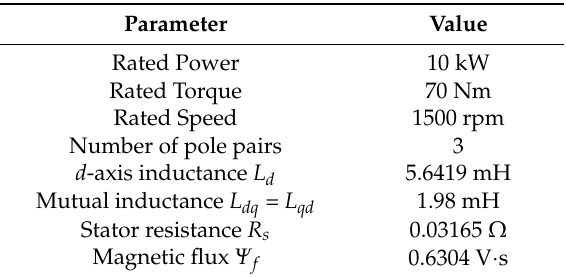
Table 1. Interior IPMSM specificaation.